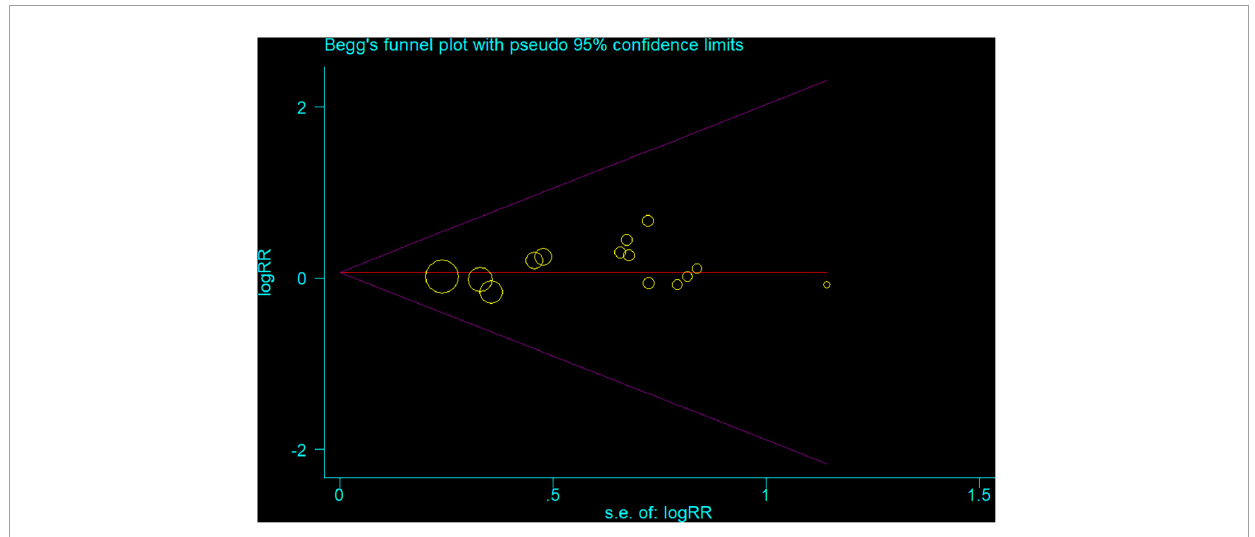
FIGURE4 Begg’s funnel plot of all 14 studies the associations between inflammatory bowel disease and the risk of Parkinson’s disease. Each point represents separate study for the indicated association.